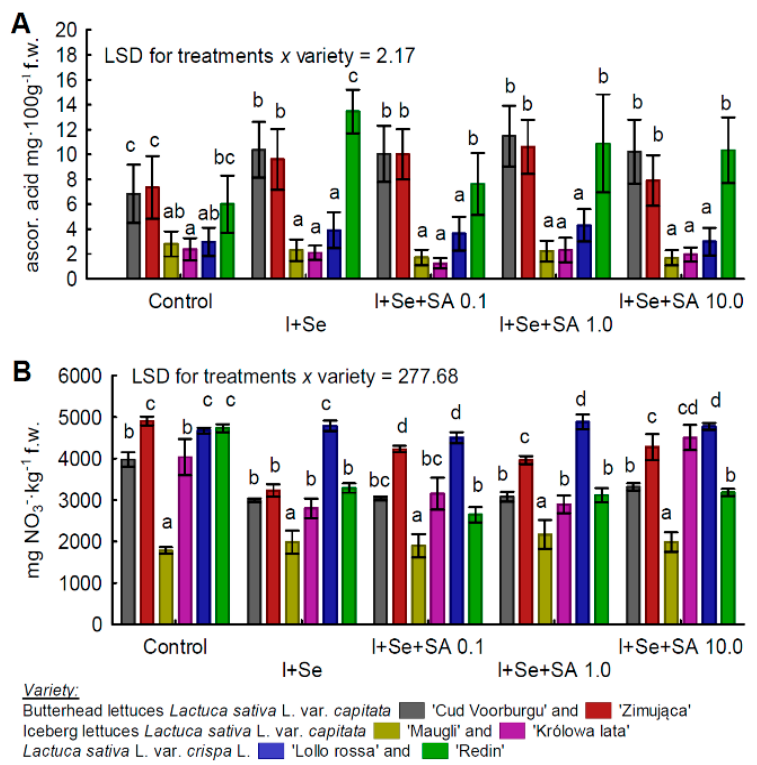
Figure 2. Concentrations of ascorbic acid ( A) and nitrate(V) (NO 3 − ) ( B ) in lettuce. Means for cultivars followed by the same letters separately for each treatment (type of nutrient solution) are not significantly different at p < 0.05. LSD (least significant difference) for interaction “treatments × variety” at p < 0.05. Bars indicate standard errors ( n = 8). f.w.—fresh matter weight.